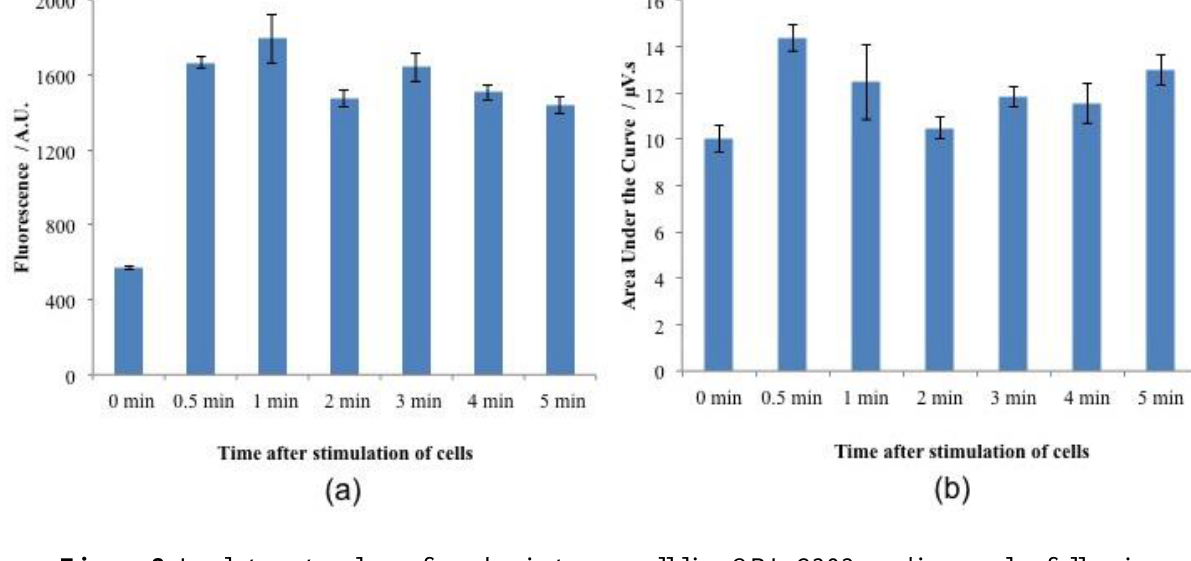
Figure 8. L-glutamate release from brain tumor cell line CRL 2303 media samples following potassium chloride (KCL) stimulation. The cells were plated in a petri dish at a density